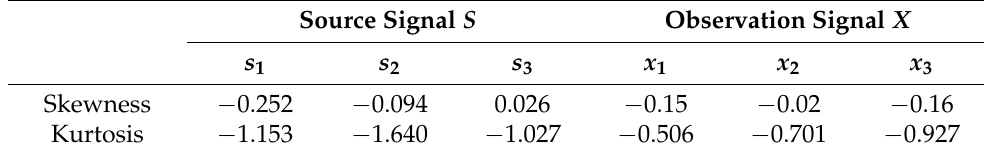
Table 5. Distribution index of simulation